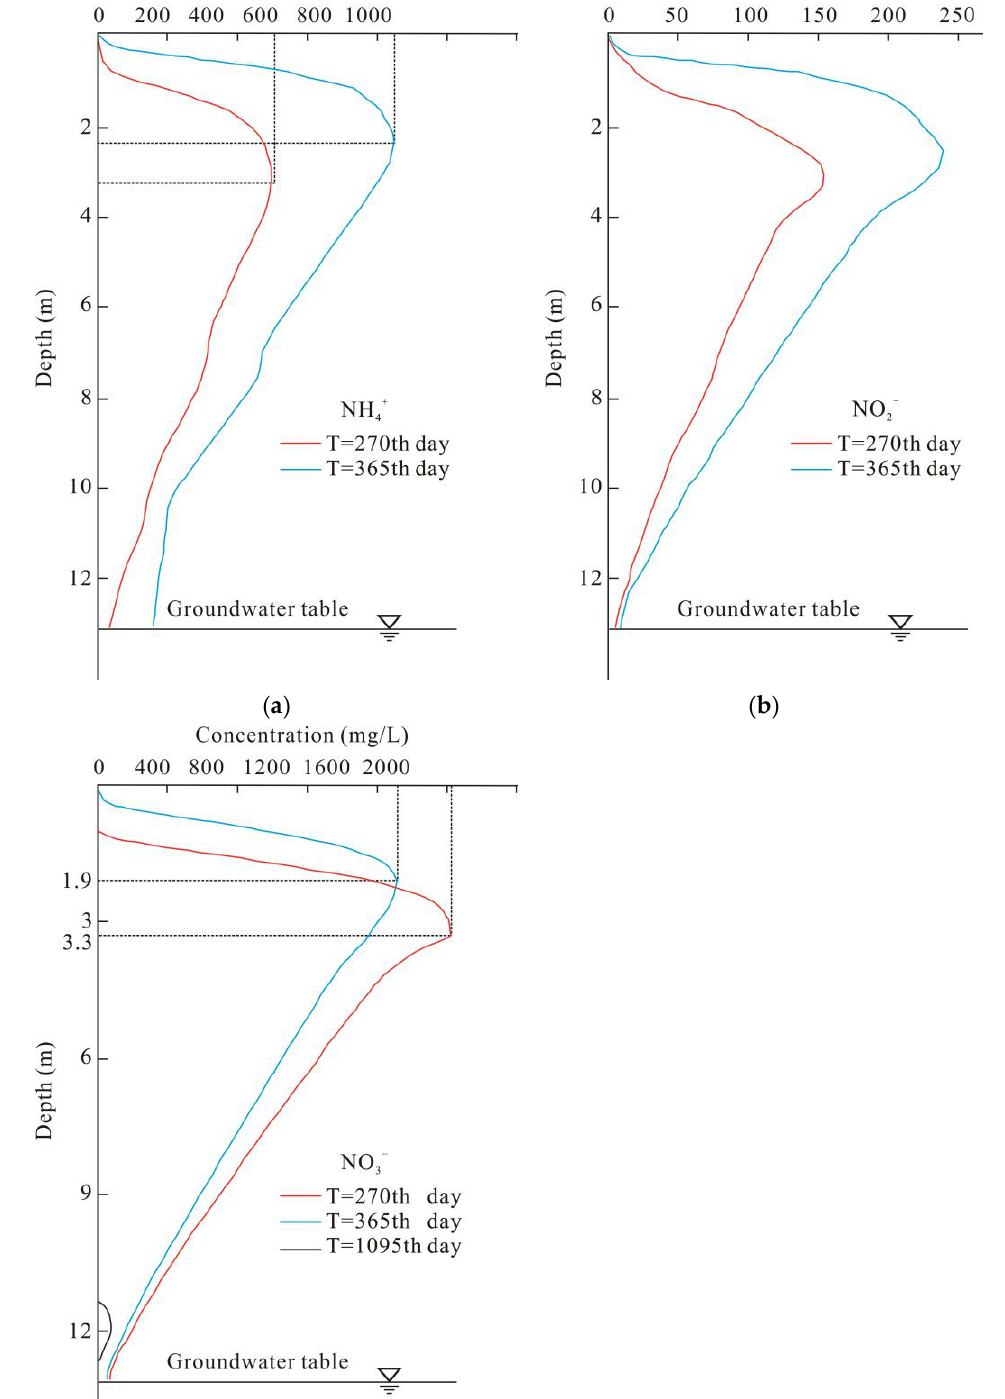
Figure 7. Vertical changes along line AA’ of ( a ) NH 4+ ; ( b ) NO 2 − ; and ( c ) NO 3 − .